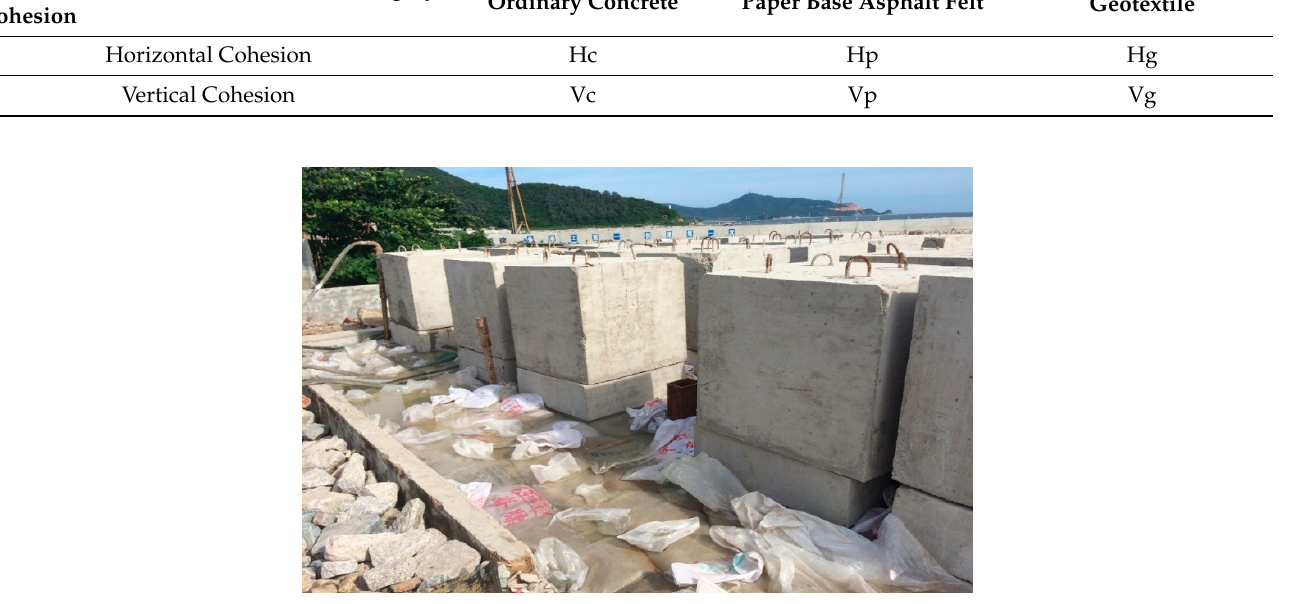
Figure 4. Layout of concrete test blocks.